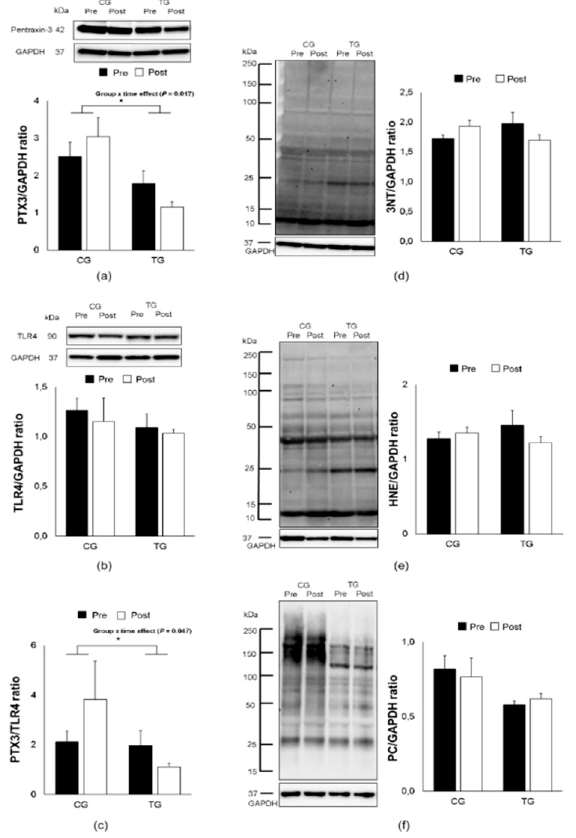
Figure 2. E ff ects of an 8-week aerobic training on PTX3, TLR4, PTX3 / TLR4 ratio, 3NT, 4-HNE and PC expression. Representative Western blots and densitometric quantification of PTX3 ( a ), TLR4 ( b ), PTX3 / TLR4 ratio ( c ) 3NT ( d ), 4-HNE ( e ), and PC ( f ) in PBMCs from elderly trained (TG) and control (CG) groups. Data are means ± SEM. The * indicates a significant ( p < 0.05) group × time e ff ect. 3NT, 3-nitrotyrosine; 4-HNE, 4-hydroxynonenal; PC, protein carbonyl; TLR4, toll-like receptor .